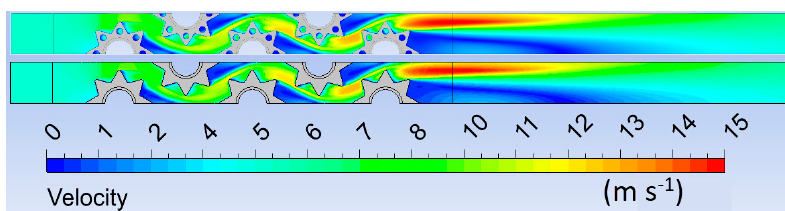
Figure 6. Velocity fields for perforated and non-perforated fins.